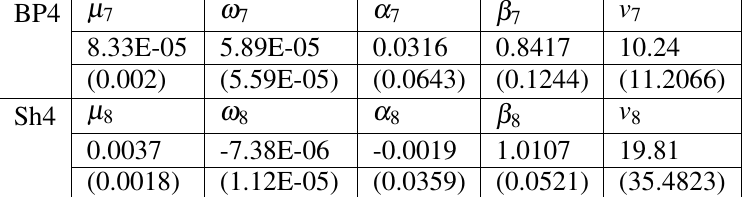
Table 8 Parameter estimation of each marginal distribution model in the third stage after the outbreak of the crisis